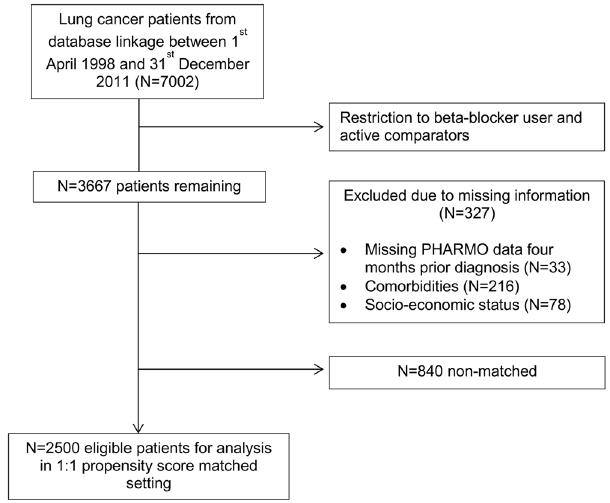
Figure 1. Selection of eligible patients for statistical